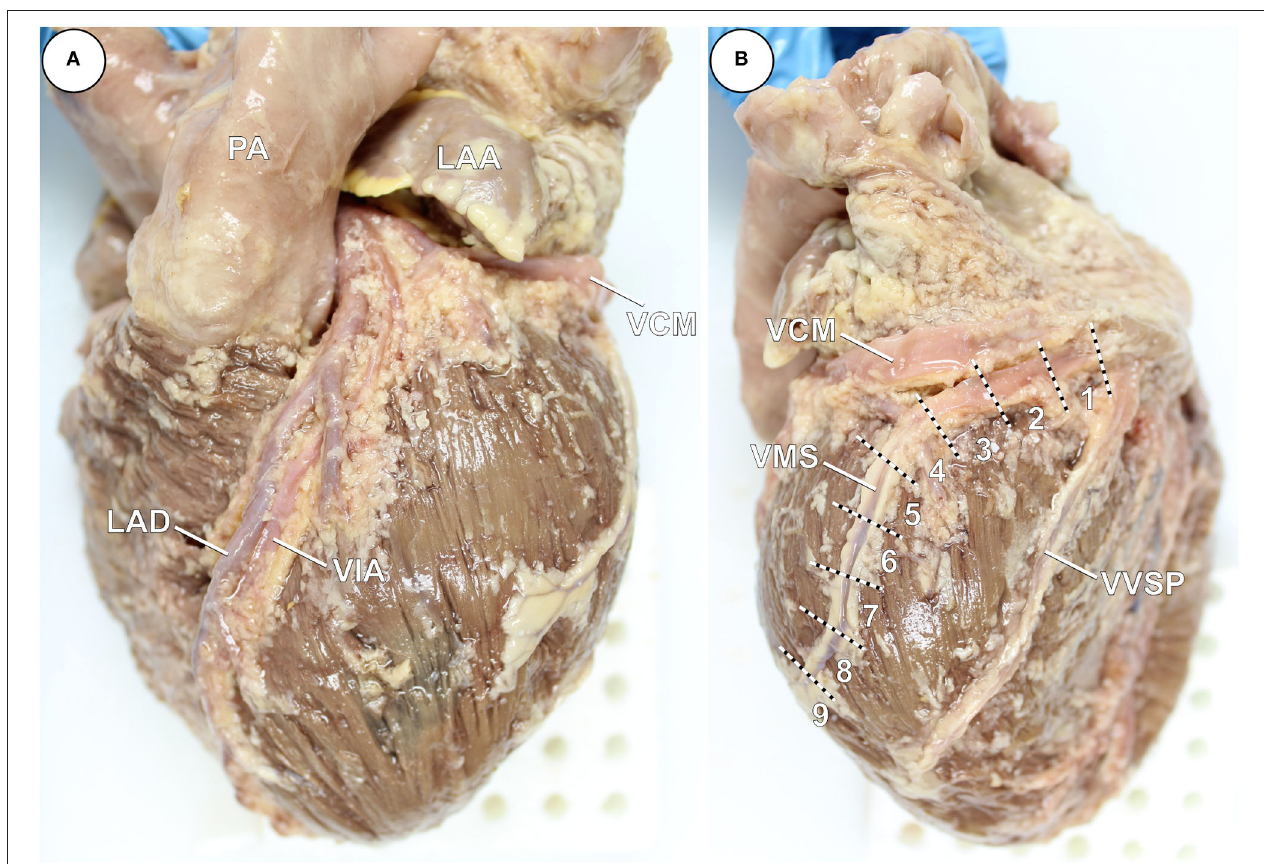
FIGURE 1 | (A,B) PFA-fixed heart from a body donor with exposed coronary veins after preparation and removed epicardial adipose tissue. (A) Left anterolateral view. (B) Right posterolateral view. Specific segments ( 1–9) of the left marginal vein (VMS) are indicated by dashed lines. LAA, left atrial appendage; LAD, left anterior descending artery; PA, pulmonary artery; VCM, great cardiac vein; VIA, anterior interventricular vein; VVSP, left posterior ventricular